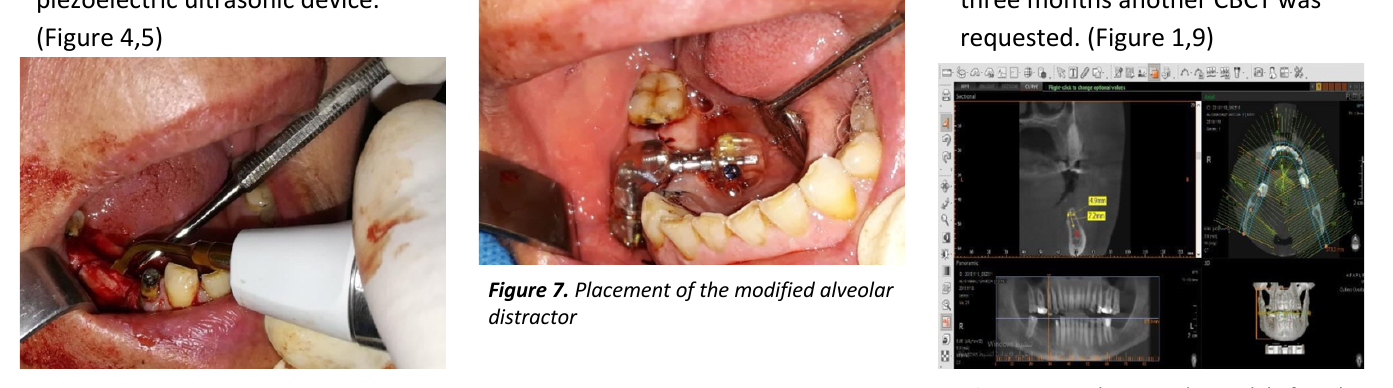
Figure 4. The bone osteotomy by Piezo- surgery.